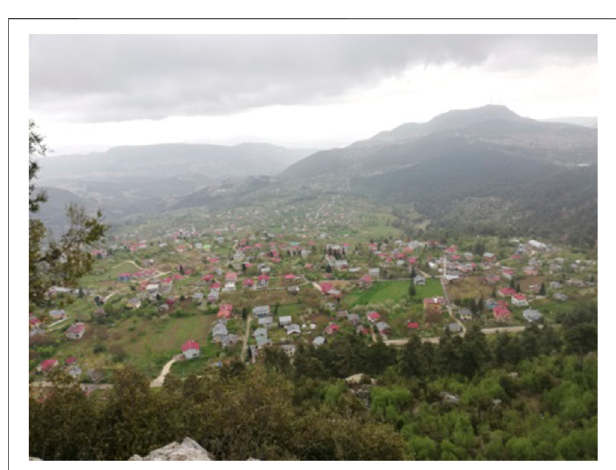
FIGURE 3 | View of Camliyayla